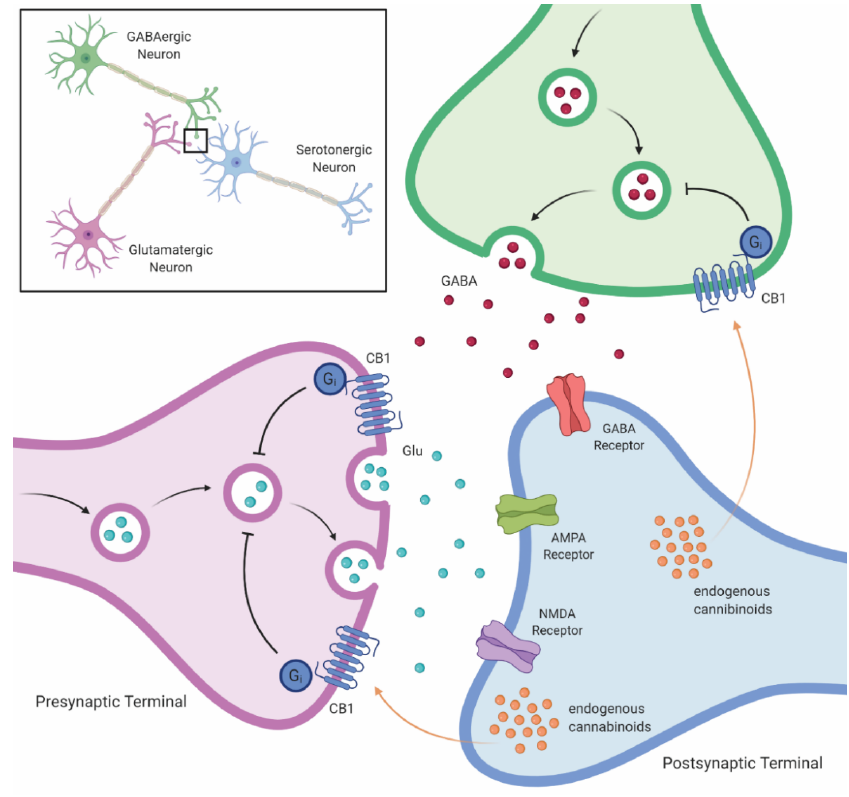
Figure 5. Cannabinoid-mediated impact on monoamine signaling in the brain. Cannabinoid-mediated stimulation of CB1 receptors on monoaminergic neurons leads to delayed transport of monoamines to the synapse, decreasing monoamines in the synapse. Abbreviations: GABA, gamma aminobutyric acid; Glu, glutamate; AMPA, α -amino-3-hydroxy-5-methyl-4-isoxazolepropionic acid; NMDA, N-methyl-D-aspartate; CB1, cannabinoid-1